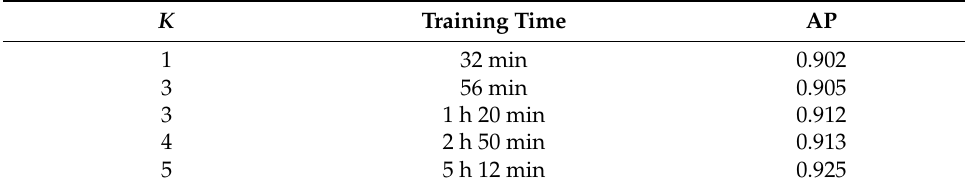
Table 2. Training Time for 200 Epochs Under Different K Values.